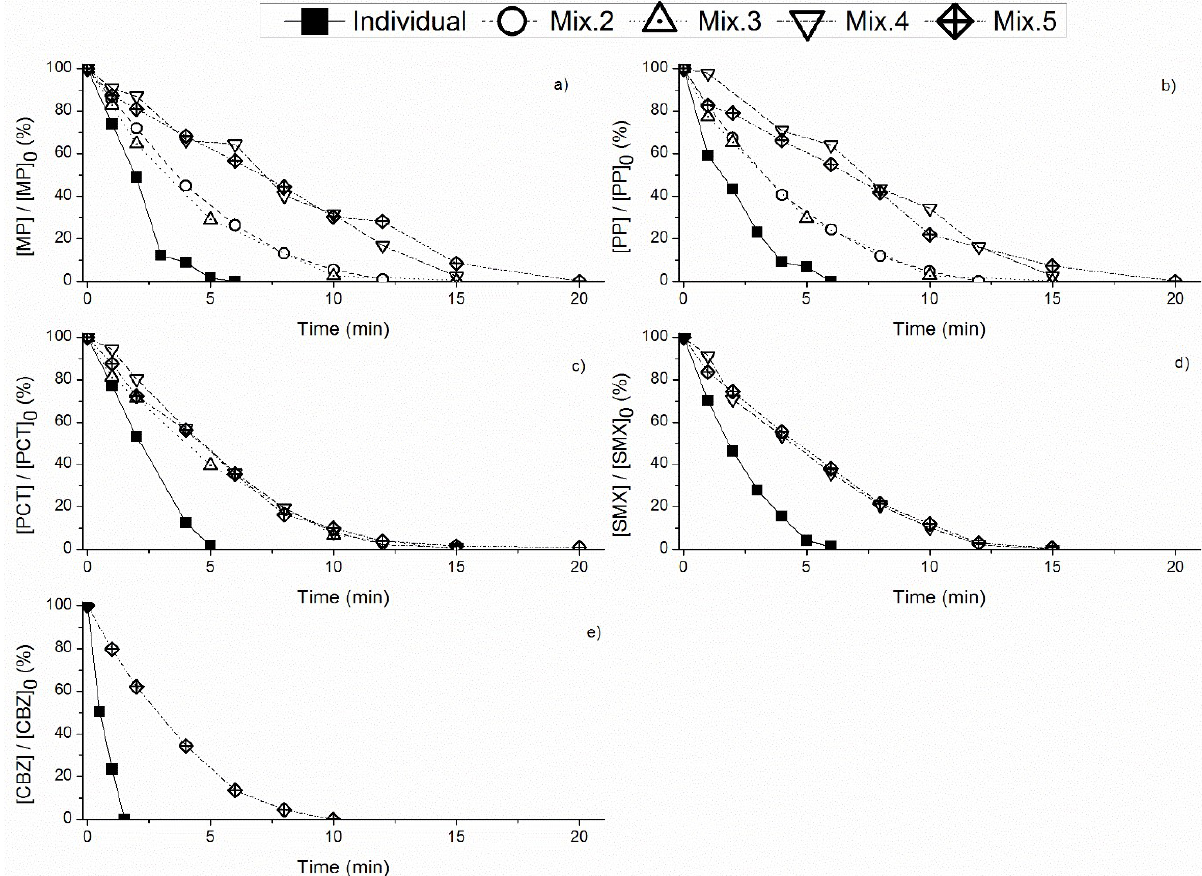
Figure 1. Normalized concentration of: ( a ) MP; ( b ) PP; ( c ) PCT; ( d ) SMX; ( e ) CBZ, during ozonation of individual PPCPs and the corresponding mixtures (Mix2, Mix3, Mix4 and Mix5), throughout the reaction time, using ultrapure water as matrix at pH 5.5 and initial concentration of each PPCP 1 mg L −1 . Mix2 included MP and PP; Mix3 included MP, PP and PCT; Mix4 included MP, PP, PCT and SMX; and Mix5 included MP, PP, PCT, SMX and CBZ. Table 2. Pseudo-first order kinetic rate constants of ozone-treated contaminants in ultrapure water (pH 5.5), individual and in mixture, as function of time. (k’ 1 ) refers to the PPCP individually, whereas k’ 2 , k’ 3 , k’ 4 , and k’ 5 , refer to Mix2, Mix3, Mix4 and Mix5, respectively (k’ a , where a is the number of contaminants in the mixture). Mix2 included MP and PP; Mix3 included MP, PP and PCT; Mix4 included MP, PP, PCT and SMX; and Mix5 included MP, PP, PCT, SMX and CBZ at 1 mg L −1 each. The corresponding adjusted coefficients of determination (adj R 2 ) are also presented.